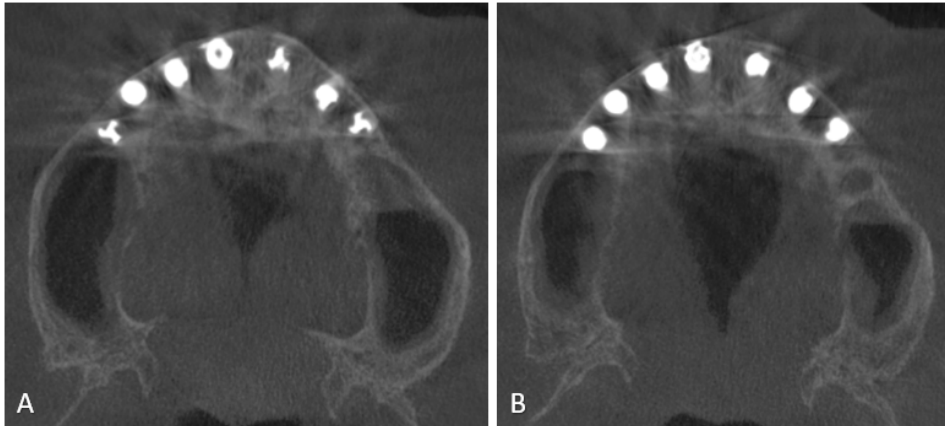
Figure 11. ( A , B ) CBCT slices of a seven-year follow-up after surgery.